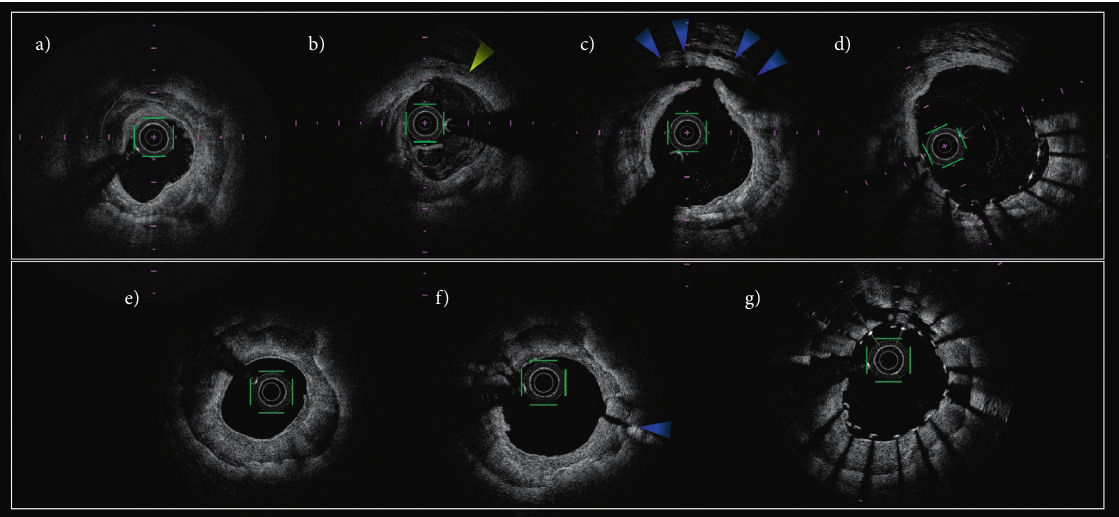
Figure 4: Representative cases of those who underwent optical frequency domain imaging (OFDI)-guided percutaneous coronary in- tervention (PCI) for severely calcified coronary disease. (a–d) A 69-year-old male with LAD lesion. Serial OFDI images obtained the same cross-section. (a) Initial OFDI image showed all rounded calcified plaque. (b) Postrotational atherectomy using a 1.5mm and 2.0 mm burr; the calcium almost disappeared within the circumference (yellow arrowhead). The lumen area was 3.5mm 2 and the lumen perimeter 6.6mm. (c) Postballooning using a cutting balloon (diameter, 3.0mm; dilatation atmosphere, 10 atm; perimeter, 10.2 mm). Blue arrowheads show the medial dissection between calcified plaque and vessel wall. (d) Final OFDI image after stenting (DES diameter was 3.5mm). The lumen area was 8.1mm 2 , and the expansion ratio (final lumen area/lumen area before ballooning) was 231%. (e–g) A 74-year-old female with LAD lesion. Serial OFDI images obtained the same cross-section. Fast view catheter (TERUMO) did not pass the lesion. Thus, there was no initial OFDI image before rotational atherectomy. (e) Postrotational atherectomy using a 1.5mm and 2.0mm burr; the lumen was totally surrounded by thick calcium. The lumen area was 3.3 mm2 and the lumen perimeter 6.4 mm. (f) Postballooning using a cutting balloon (diameter, 2.25mm; dilatation atmosphere, 8 atm; perimeter, 7.3mm). The sheet calcium was cracked without medial dissection (blue arrowhead). (g) Final OFDI image after stenting (DES diameter was 2.5mm). The lumen area was 4.6mm 2 and the expansion ratio (final lumen area/lumen area before ballooning) was 139%. DES, drug-eluting stent; LAD, left anterior descending artery; OFDI, optical frequency domain imaging; PCI, percutaneous coronary